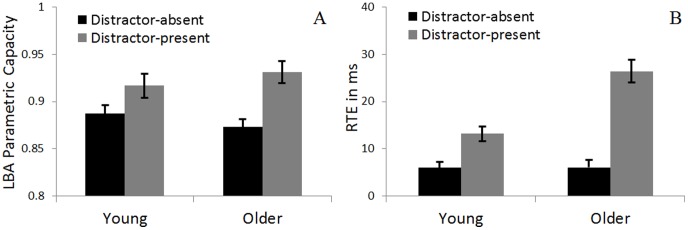
A comparison of LBA parametric capacity estimates vRT/vST, Panel A and redundant target effect (RTE) in ms, RT(redundant-target) – RT(fastest single-target), Panel B.Comparing the two panels it is clear that the LBA parametric capacity follows the trend observed in the raw latency analysis. Mainly, adding a distractor to the task increases both measures, yet this increase is doubled for older adults.